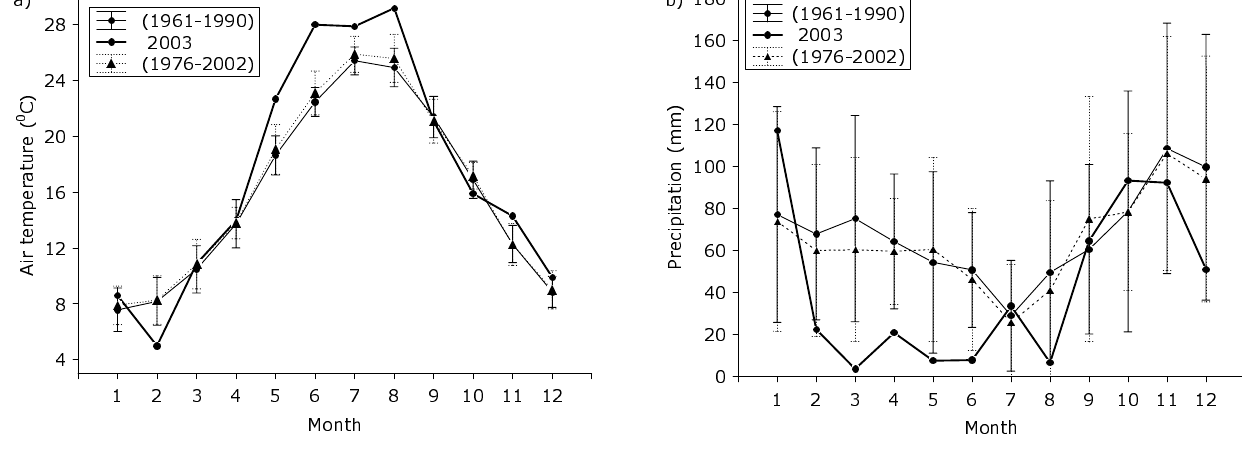
Fig. 2b. Annual cycle of monthly mean precipitation at Split- Marjan for the periods 1961–1990 and 1976–2002 and for the year 2003. Vertical bars represent interannual standard deviations for particular